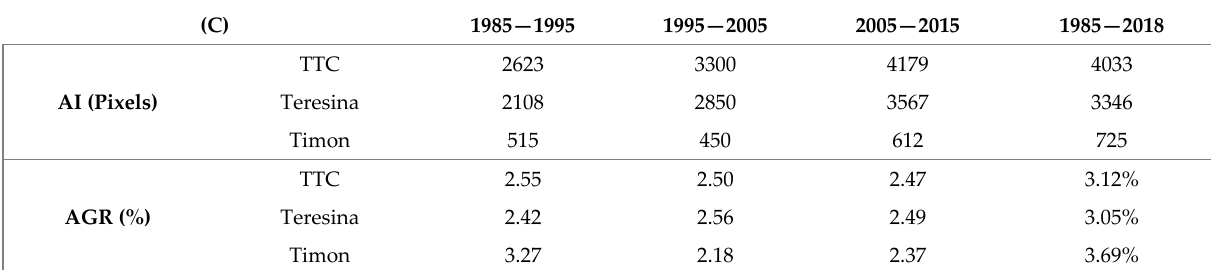
Figure 7. ( A ) Annual increase (AI) (in pixels) for each year from 1985 to 2018 for: TTC area (grey); Teresina (red); and Timon (blue). ( B ) Normalized annual urban growth rate (AGR) (%) for each year from 1985 to 2018 for: TTC area (grey); Teresina (red); and Timon (blue). ( C ) AI and AGR computed for decades: 1985 — 1995, 1995 — 2005, 2005 — 2015, and the average for 1985 — 2018 period.